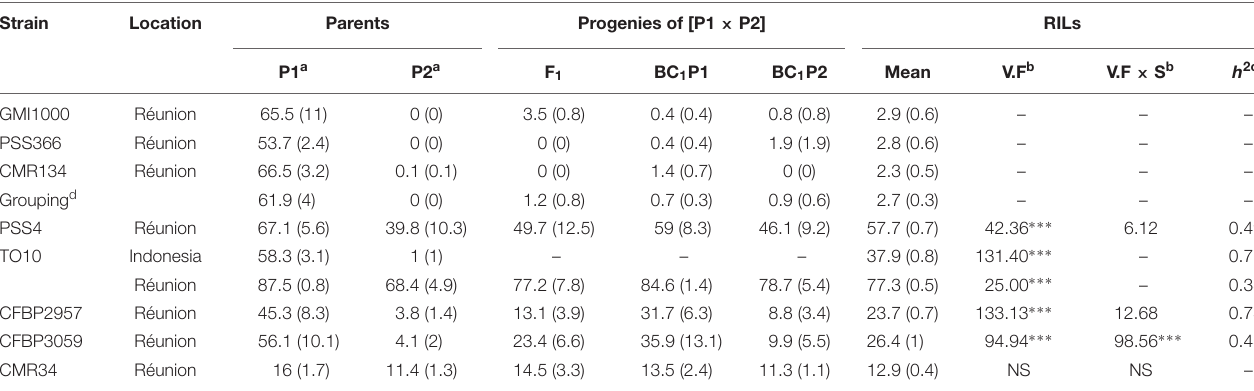
TABLE 3 | Mean Waudpc values (with standard errors) for parents P1 (MM738), P2 (AG91-25) and their progenies, obtained with eight R. solanacearum species complex strains. Strain